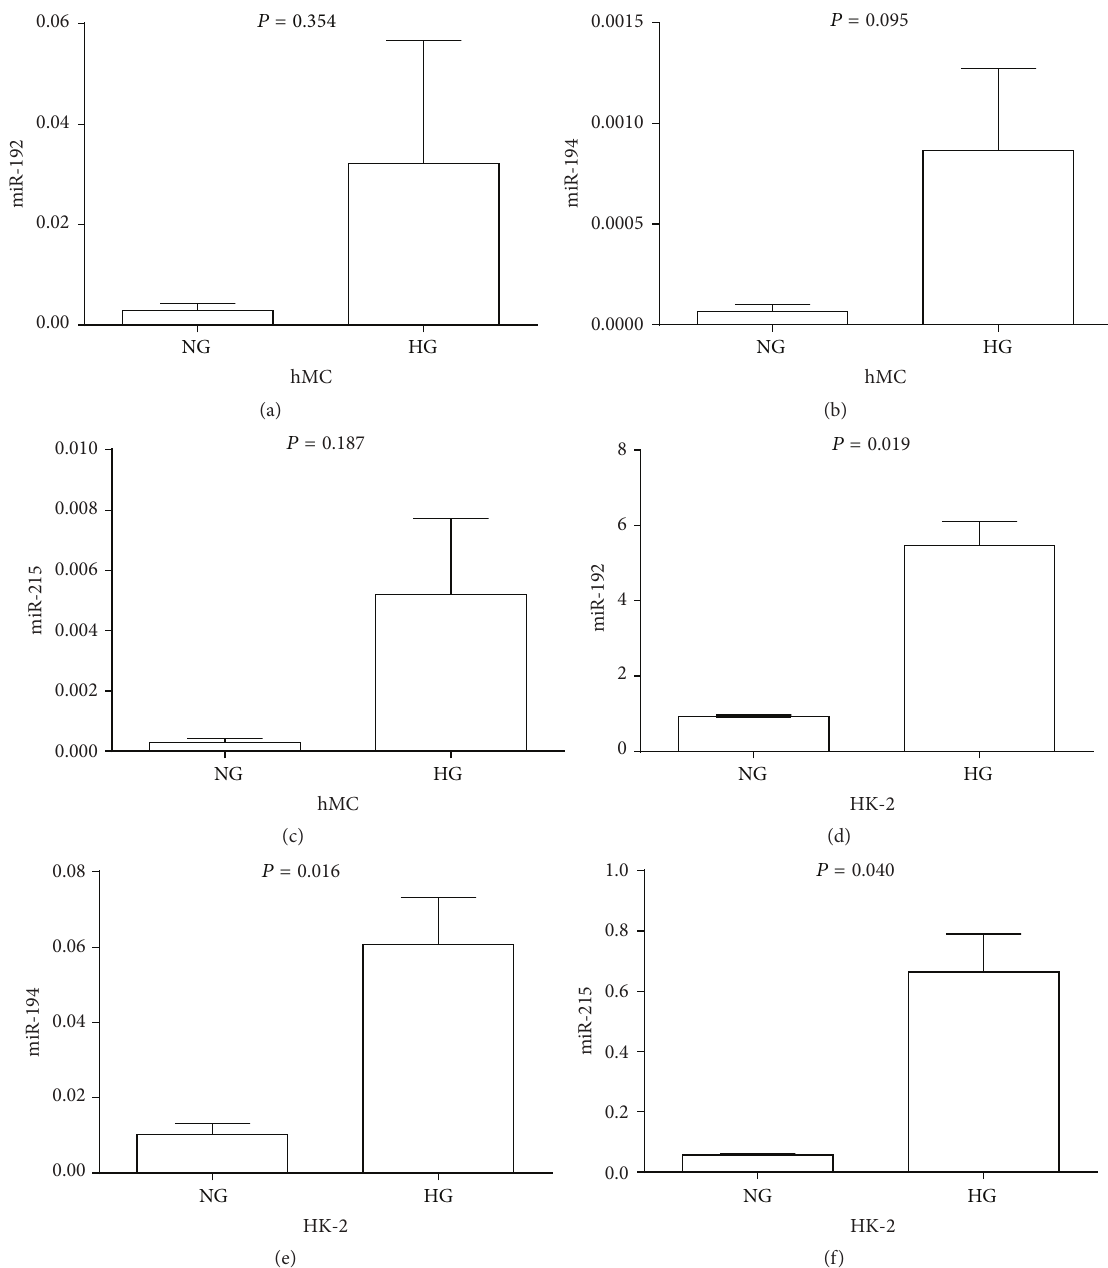
Figure 5: miRNAs expression from human proximal tubule and mesangial cell supernatant EVs. Human proximal tubule and mesangial cells were exposed to high glucose for 48h. RT-PCR analysis was used to measure miRNA expression (a–c) from hMCs (d–f) from HK-2 cells. miRNAs levels were normalized to cel-miR-39 and were calculated using the 2 −Δ CT method ( 𝑃 < 0.05